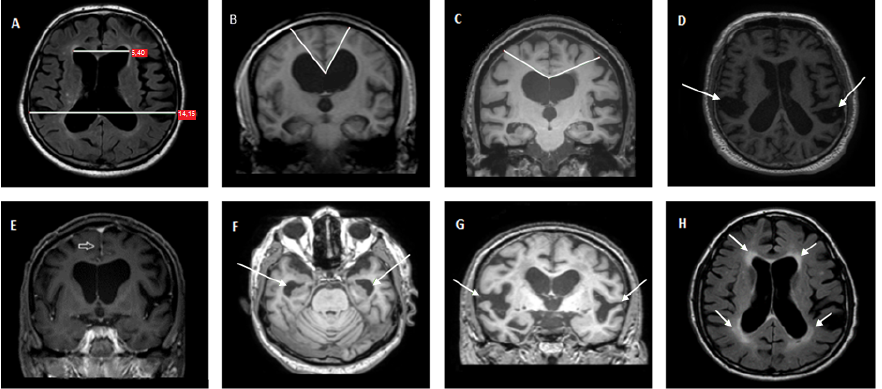
Figure 1. Brain T1-weighted (B-G) and FLAIR ( A , H ) MRI images of patients of this study. Arrows are pointing to the areas of interest of each imaging parameter. Evan’s Index measurement